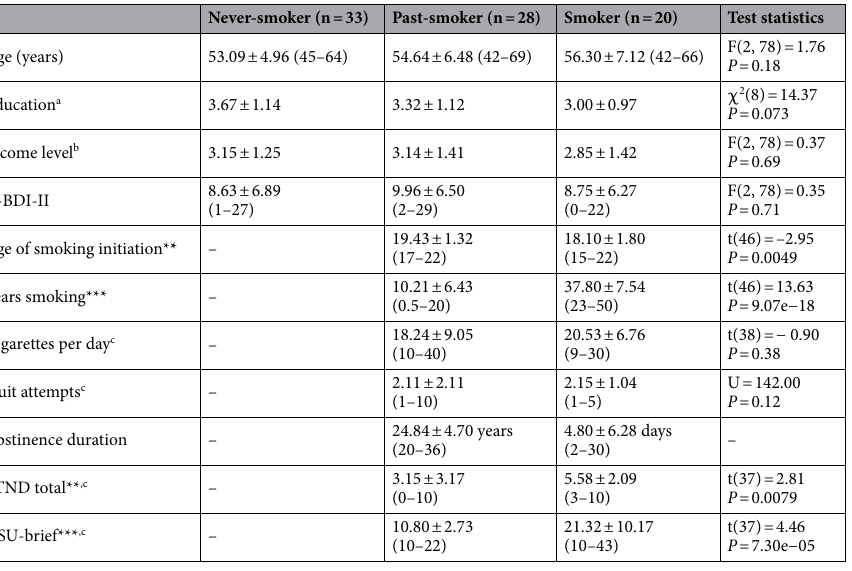
Table 1. Demographic information and smoking measures. Means ± SDs and the range ([min–max]) of each item are reported. K-BDI-II, Korean Version of Beck Depression Inventory, Second Edition 61 ; FTND, Fagerström Test for Nicotine Dependence 57,58 ; QSU-brief, brief Questionnaire of Smoking Urges 59 . a Average education where 1 = ≤ middle school graduate, 2 = high school graduate, 3 = some university or community college graduate, 4 = Bachelor’s degree, 5 = ≥ Postgraduate studies. b Average household monthly income